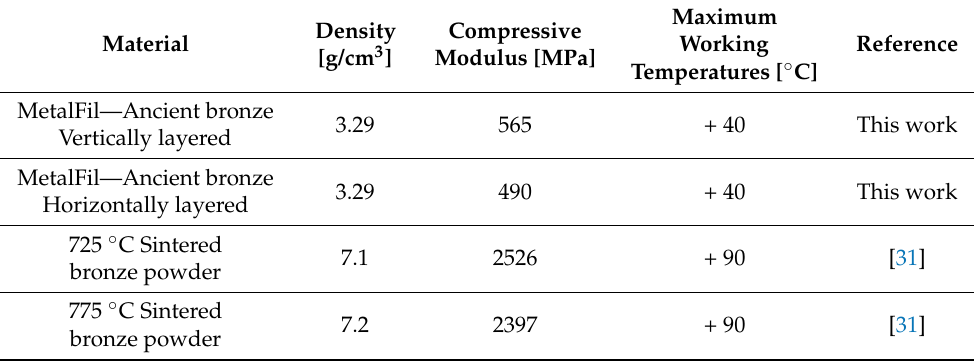
Table 3. Compressive modulus comparison between FDM 3D printed bronze-filled PLA and 60 min sintered bronze